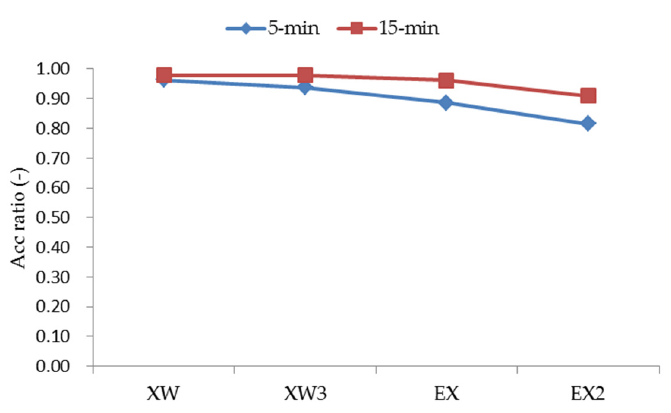
Figure 9. Chart of Acc for production nodes at different levels.